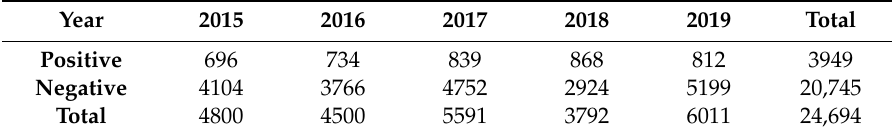
Table 1. Cases of bacteremia distributed by year.